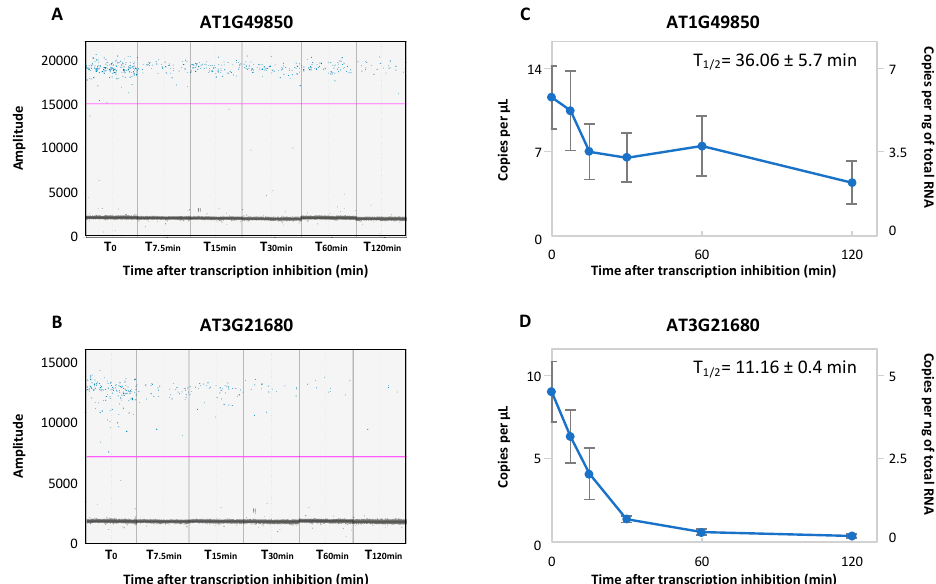
Figure 4. ddPCR allows monitoring of the mRNA half-life of lowly expressed transcripts. A ddPCR amplitude plot for AT1G49850 ( A ) and AT3G21680 ( B ) during the transcription inhibition time course. The blue and grey dots correspond, respectively, to the positive and negative droplets. The pink lines correspond to the threshold and were manually applied, respectively, at 15,000 and 10,000 to AT1G49850 and ATG321680. ( C , D ). The number of copies per µ L or per ng of the total RNA obtained in A and B, respectively. N = 3 biological replicates. Mean ± SD.